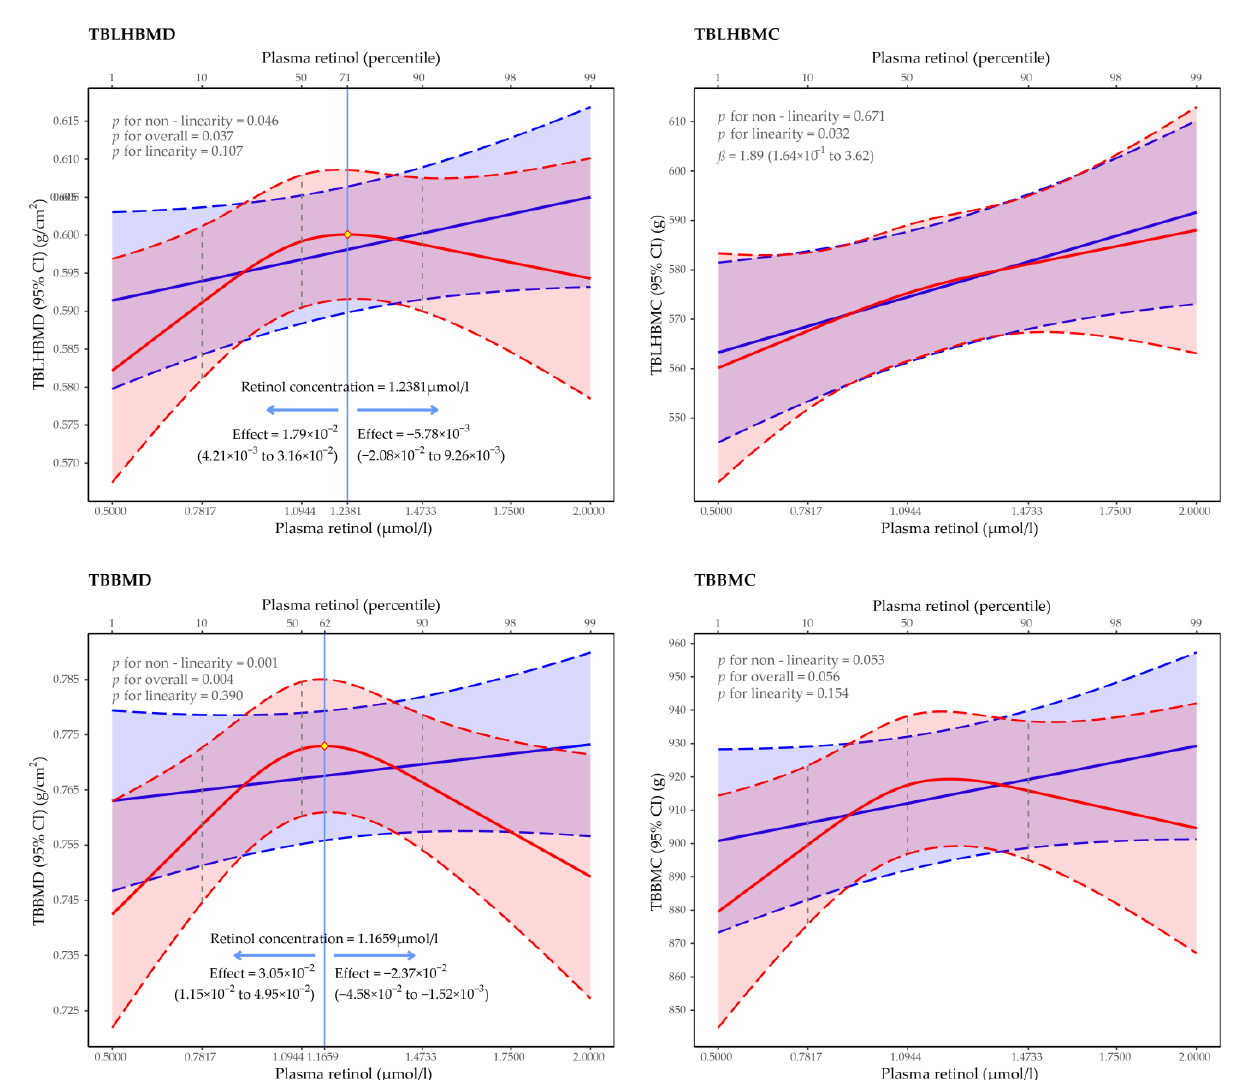
Figure 1. Association of predicted plasma retinol concentration with bone mineral indexes in children who were aged 6–9 years. Average predicted values of bone mineral indexes are indicated by solid lines, and 95% CI are indicated by shaded areas with lower, and upper values are indicated by dash lines (red: non-linearity, blue: linearity). Knots of plasma retinol concentration were placed at 10th (0.7817 µ mol/L), 50th (1.0944 µ mol/L) and 90th (1.4733 µ mol/L) centiles according to the distribution of data, and these are indicated by vertical dash segment. The predicted maximum values of TBLH BMD and TB BMD are indicated as yellow diamond and blue vertical line, respectively. TB, total body; TBLH, total body less head; BMD, bone mineral density; BMC, bone mineral content.